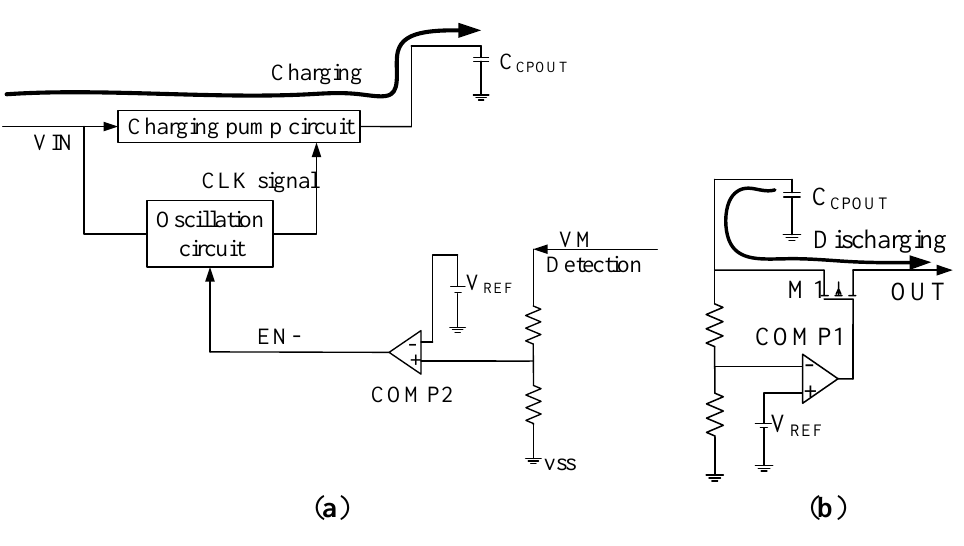
Figure 3. Schematic of S-882Z22. ( a ) Principle of charging mode; ( b ) Principle of discharging